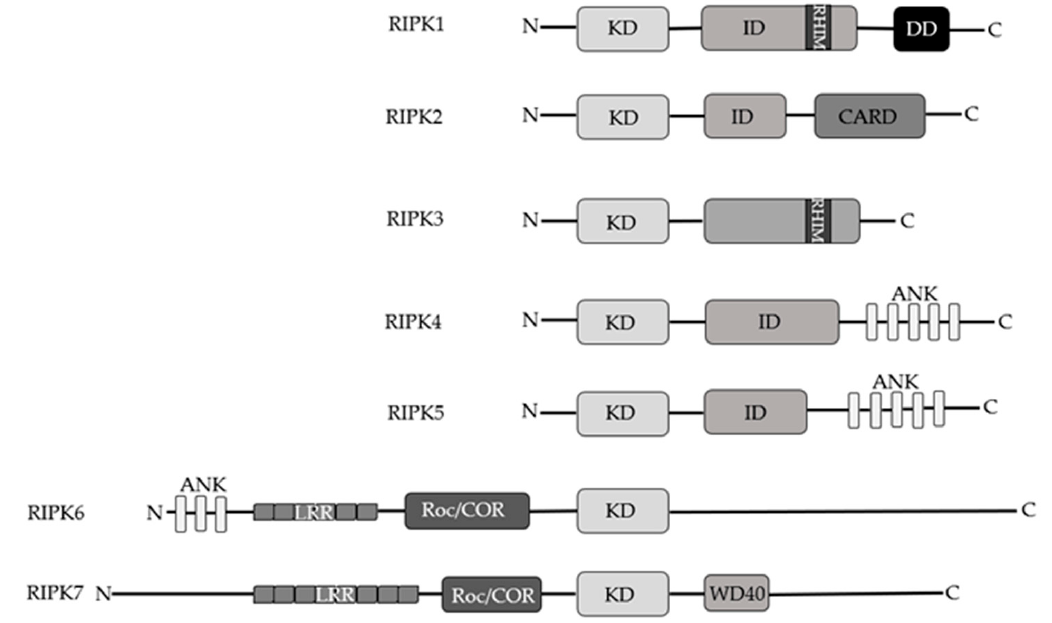
Figure 2. Schematic representation of RIP kinases family’s members.